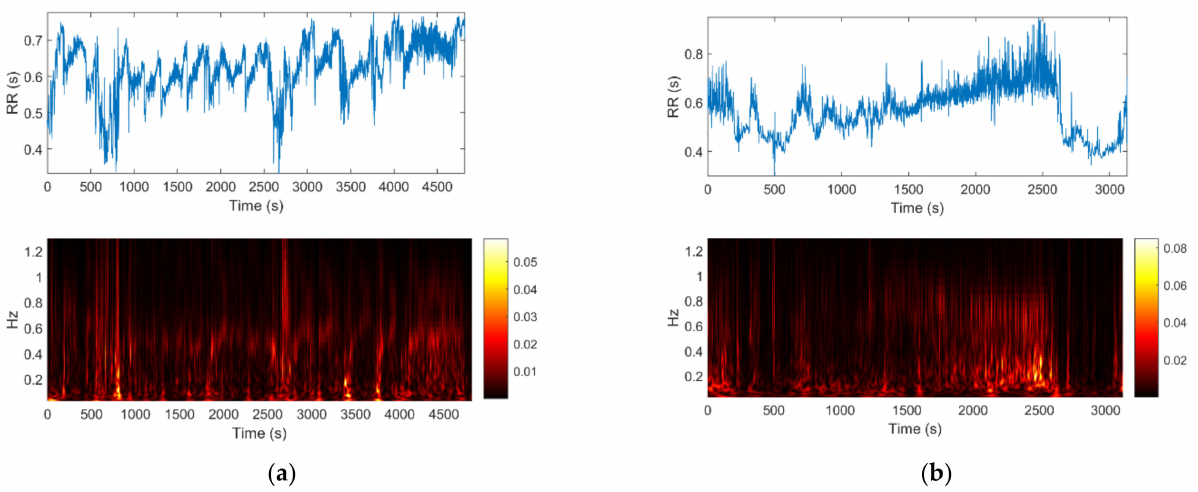
Figure 1. ( a ) Newborn with seizure events. ( b ) Seizure-free subject. Above: inter-beat (RR) time series extracted by Kubios. Below: the corresponding time-frequency representation using Continuous Wavelet